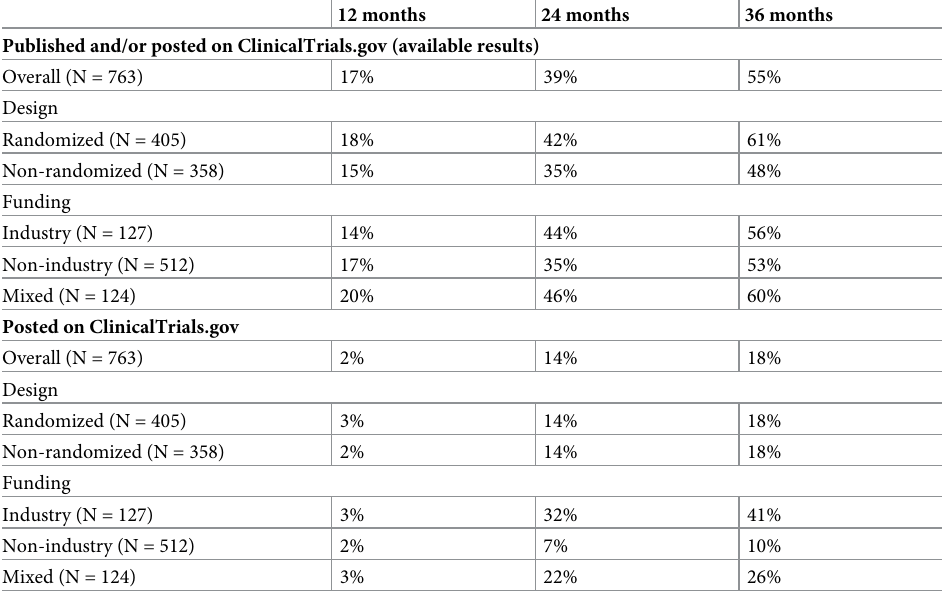
Table 2. Cumulative percentages of interventional studies with available or posted results over time, according to study design and type of funding. Published and/or posted on ClinicalTrials.gov (available